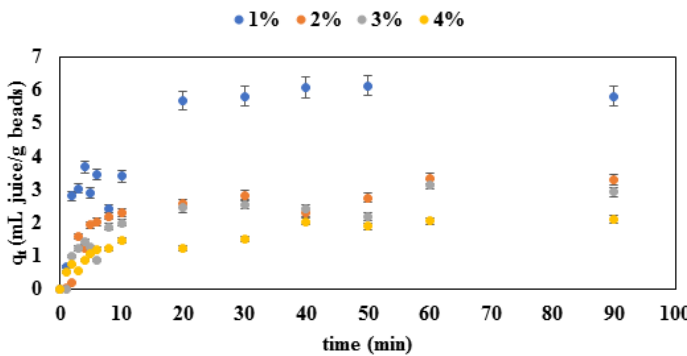
Figure 6. Concentration change dynamics during the desorption process of the red beetroot dye on alginate microbeads. Table 4. Parameter estimates for the desorption process. Values in brackets represent standard errors of model estimates. Values with an asterisk (*) represent significant values at p < 0.05. Model/Parameter